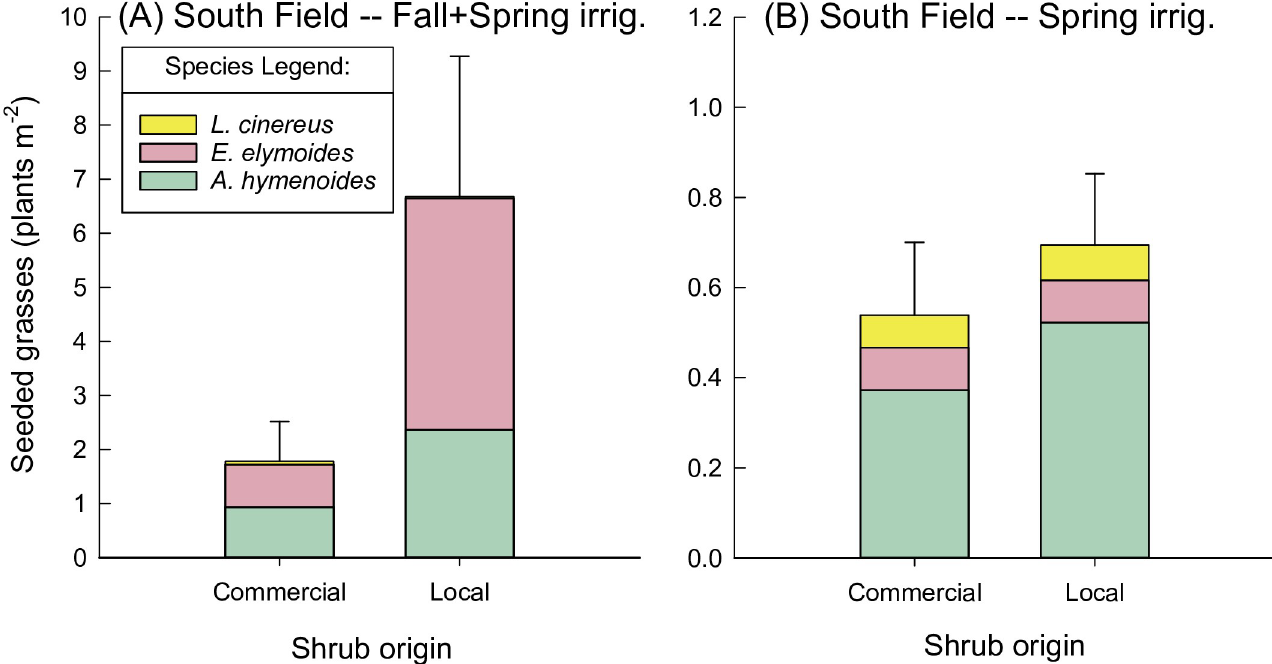
Fig 7. Seeded grasses in the South Field in May 2017, by irrigation treatment and shrub origin. Seeded grasses (plants m -2 ) in May 2017, excluding Sporobolus airoides (which had only one origin), shown by shrub origin for the (A) South Field, Fall+Spring irrigation, and (B) South Field, Spring irrigation. Note the larger scale in panel (A) vs. (B). Densities of S . airoides averaged 0.07 ± 0.02 and 0.52 ± 0.13 plants m -2 in the Fall+Spring and Spring irrigation, respectively.